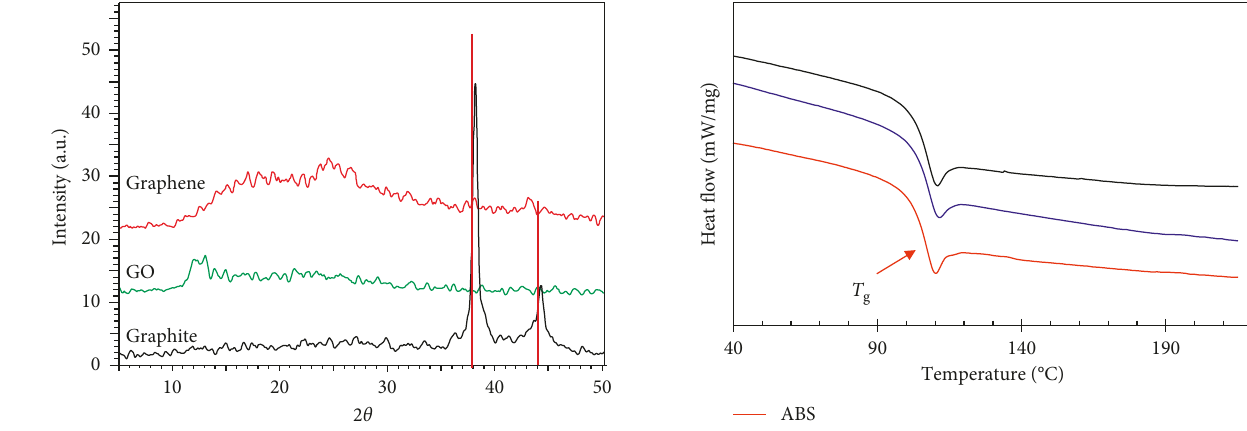
Figure 2: XRD diagram of graphite, graphene, and graphene oxide (GO).